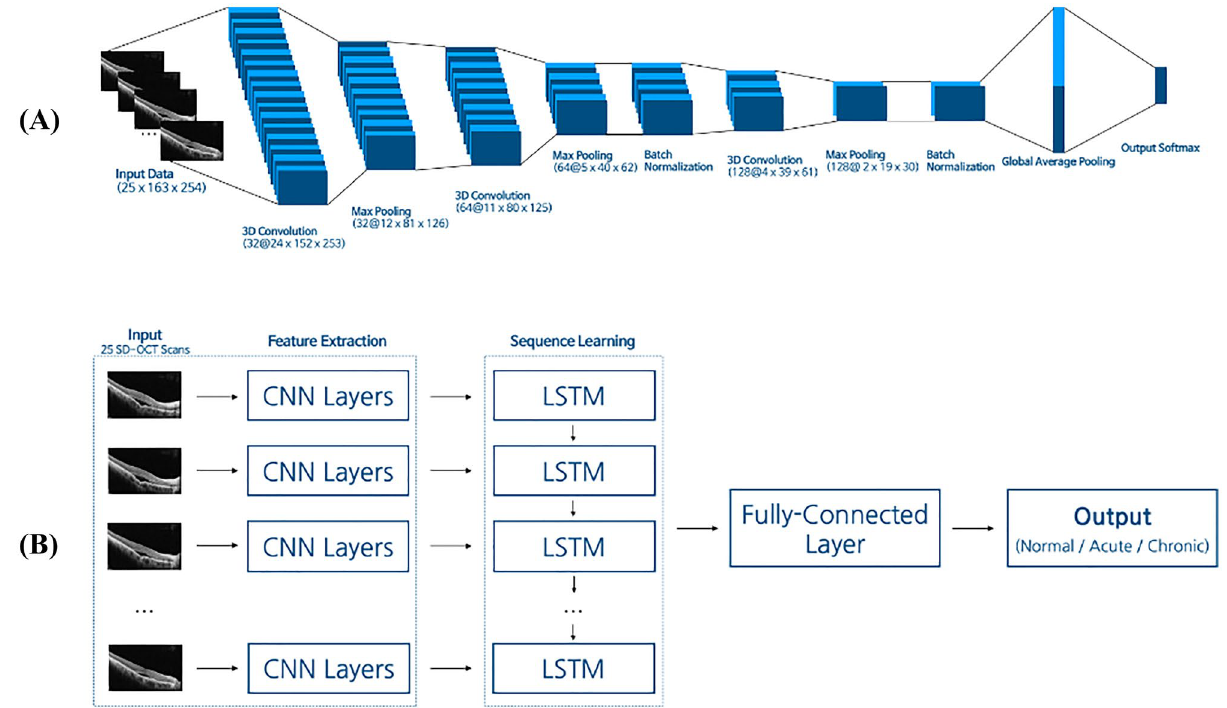
Figure 4. An illustration of the baseline models (CNN-LSTM, 3D-CNN). ( a ) The 3D Convolution module extracted spatial and temporal features from the 25 SD-OCT cuts. The last fully connected layer classified each class using a 3D image description vector extracted from the 3D convolution module. The number in front of ‘@’ denotes the filter size, and after the ‘@’ is the size of the output vector. ( b ) The CNN-LSTM (Convolutional Neural Network—Long Short Term Memory) model used CNN as the feature extractor, LSTM for sequence learning, and the fully connected layer as a classifier. The CNN architecture summarized a single image into a latent vector. LSTM analyzed each latent vector from each image. The final classifier predicted the labels using outputs of LSTM. The LSTM layers contain 64 cells. Acute and chronic in the output box indicate acute CSC and chronic CSC,